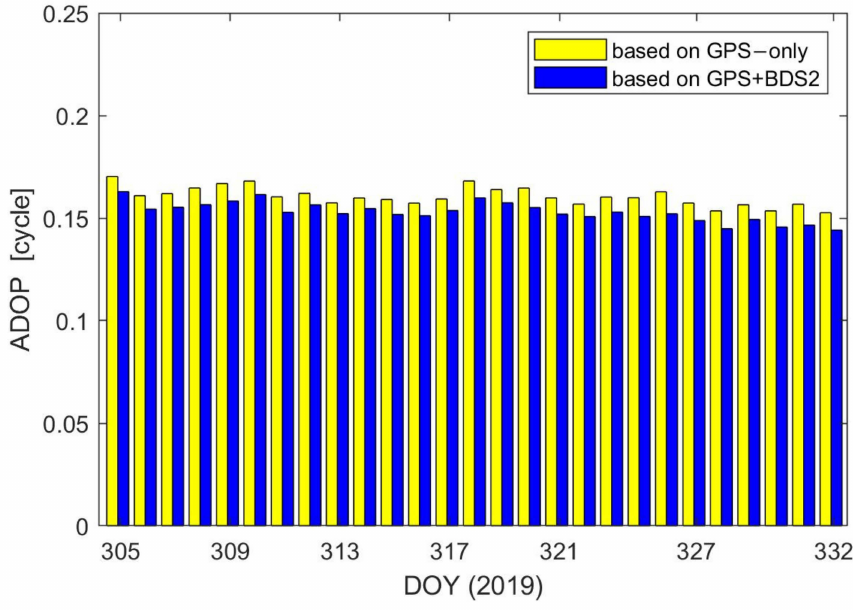
Figure 16. Daily value of GPS